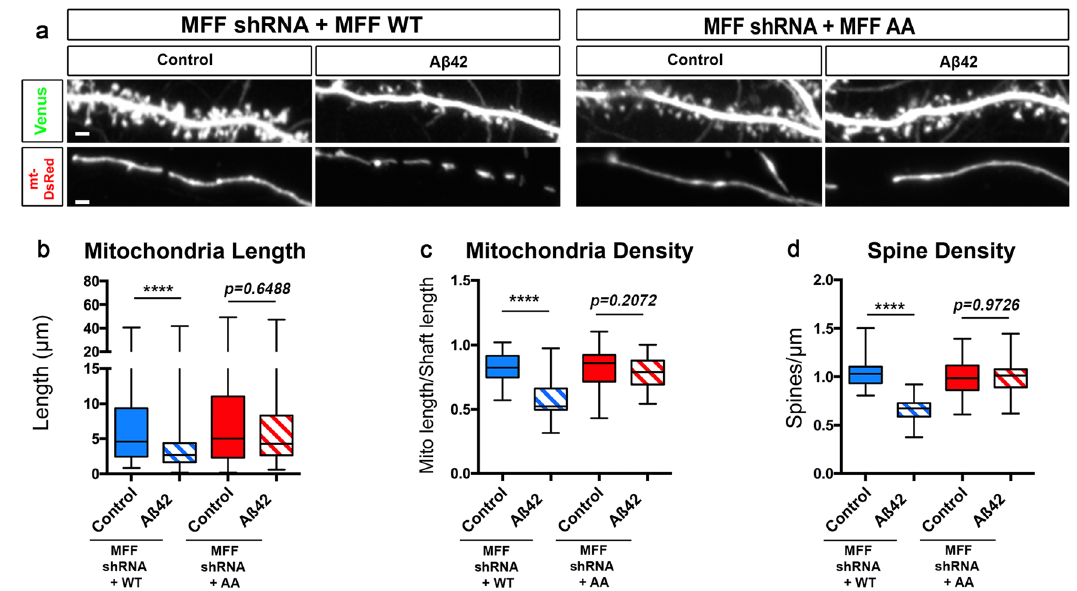
Fig. 7 | A β 42o induces AMPK-dependent MFF phosphorylation at two serine sites required for A β 42o-dependent dendritic mitochondrial fragmentation and spine loss. a Representative images of secondary dendritic segments of primary cortical PNs at 21 DIV. Embryos at E15.5 were ex utero electroporated with pCAG-Venus, pCAG-mito-DsRed, MFF shRNA, and low levels of either pCAG-MFF-WT cDNA or phospho-dead pCAG-MFF-AA. At 20DIV, the neurons were treated with either a vehicle control or A β 42o for 24h. Gene